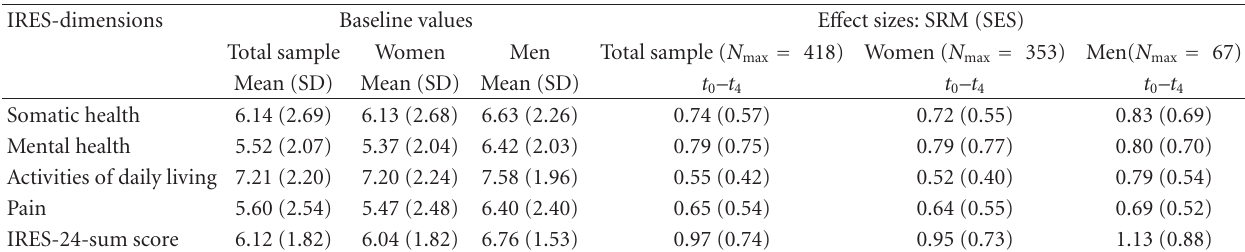
Table 3: Health related quality of life